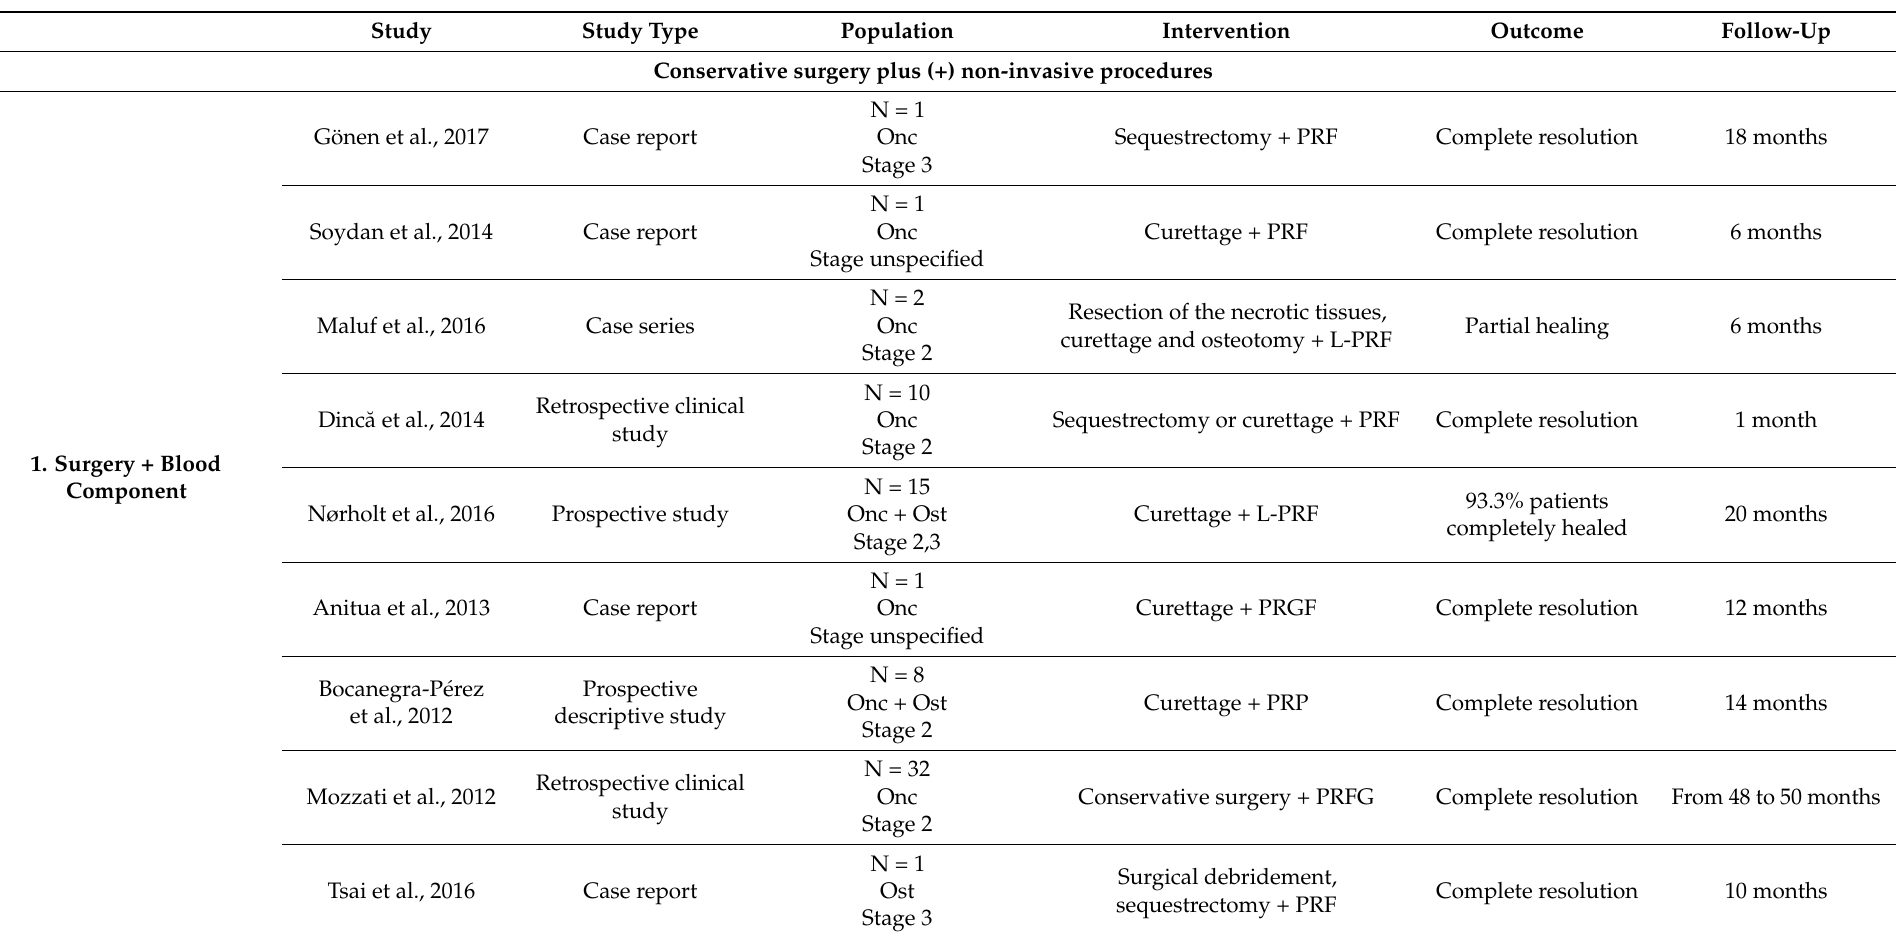
Table 3. Summary of the characteristics and the results of the studies on MRONJ surgery plus non-invasive